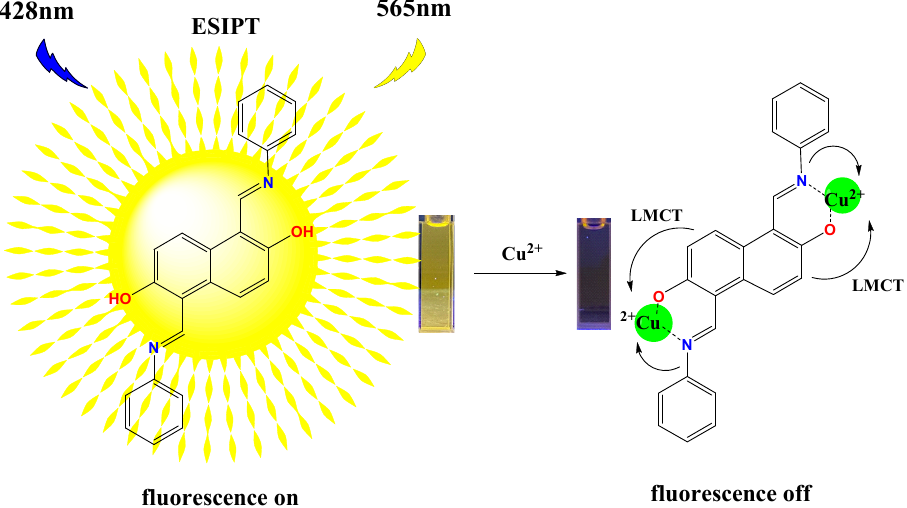
Figure 9. The possible recognition mechanism process for detection of copper ions.